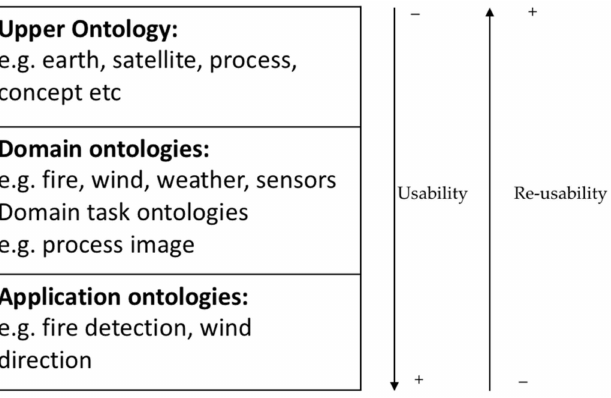
Figure 2. Three ontology levels